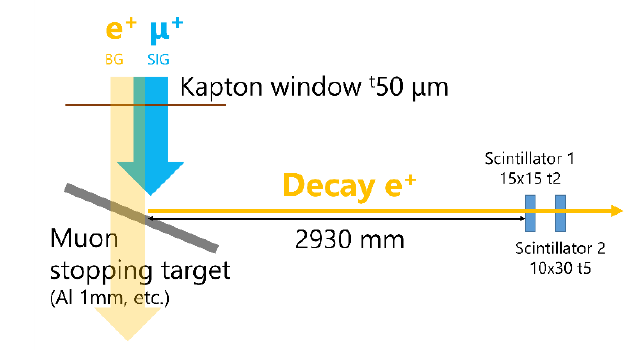
Fig. 1. Experimental setup to measure the intensity of surface